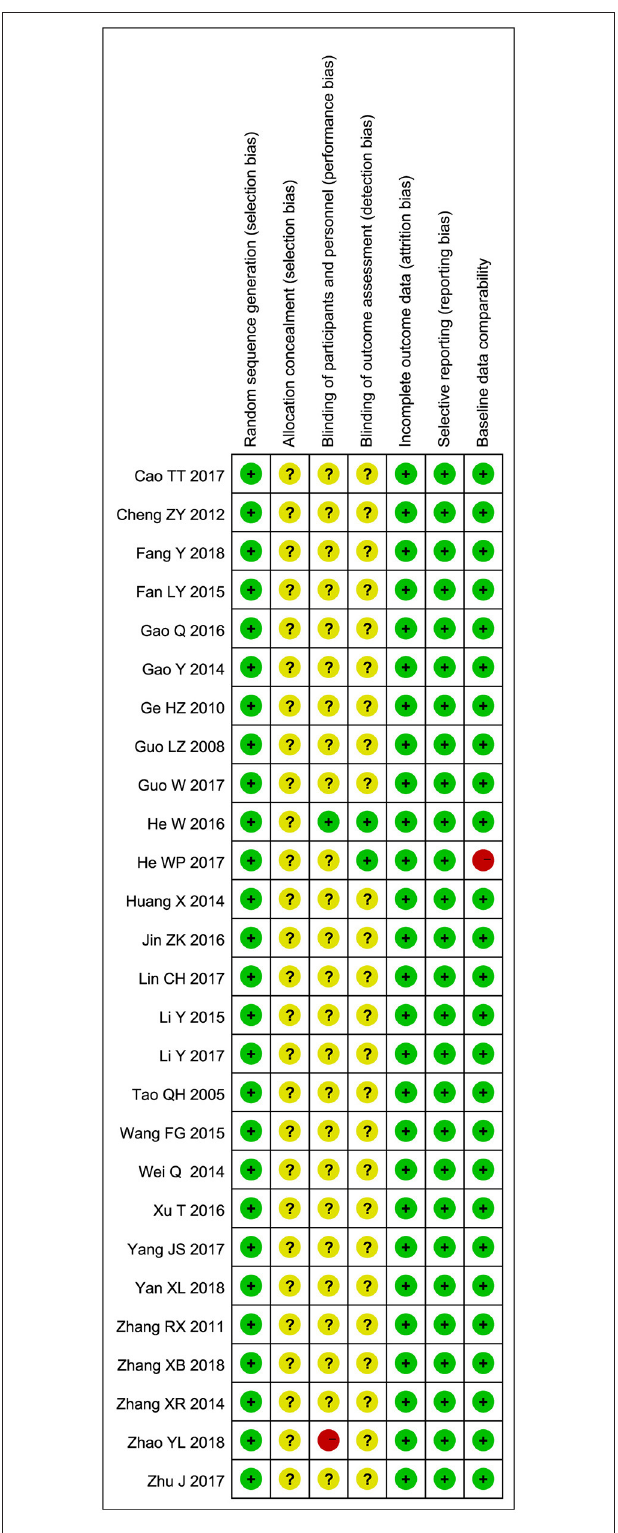
FIGURE 2 | Risk of bias